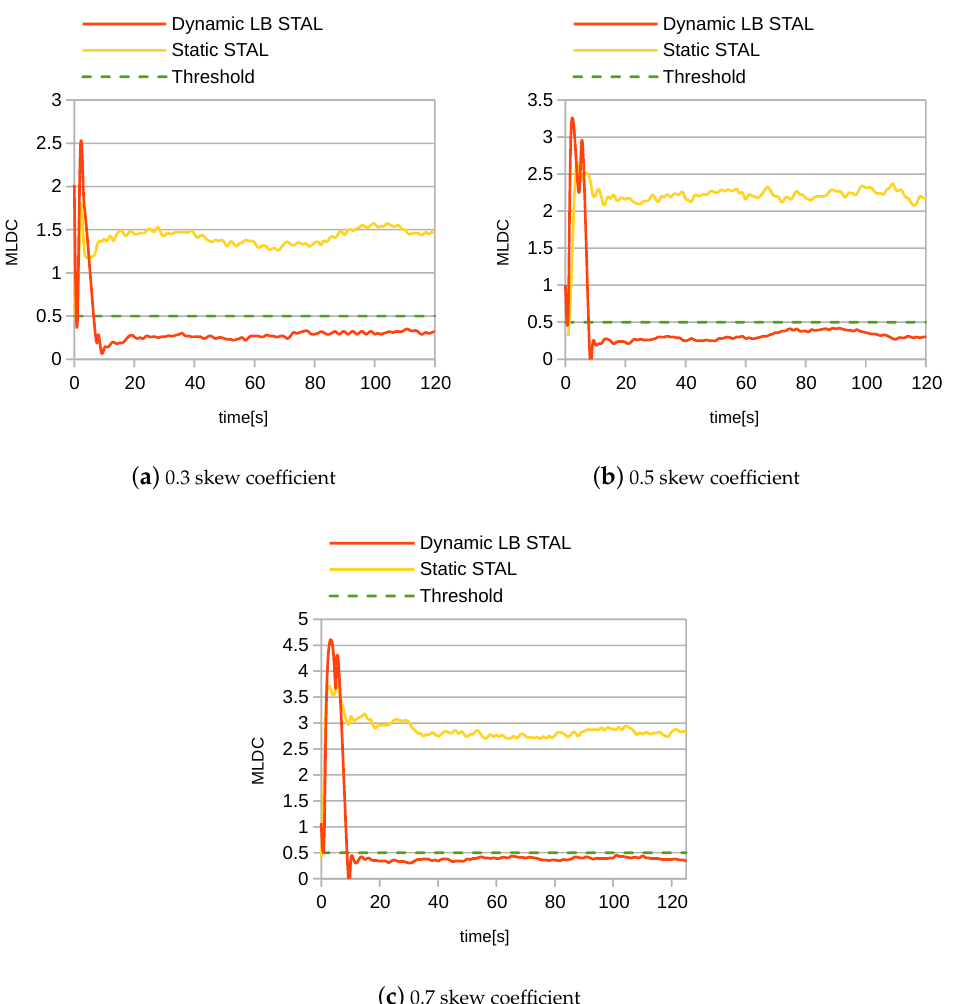
Figure 7. Maximum Load Distance Coefficient (MLDC) against time for different modes of the sPS